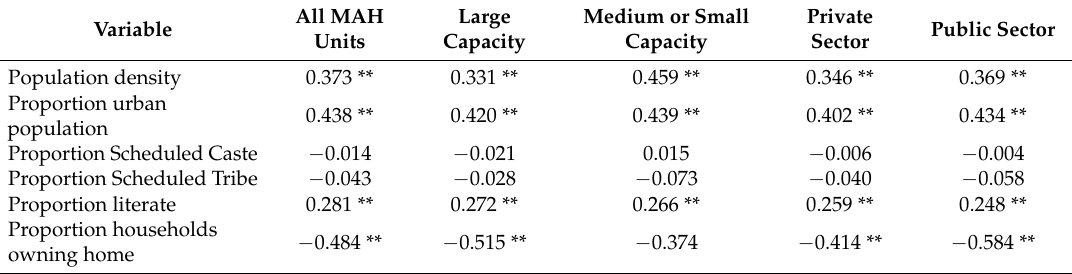
Table 2. Bivariate correlations (Pearson’s r ) between dependent and independent variables.